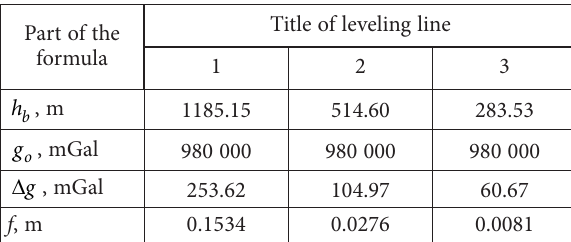
Table 1. Values of corrections f in leveling lines Part of the formula